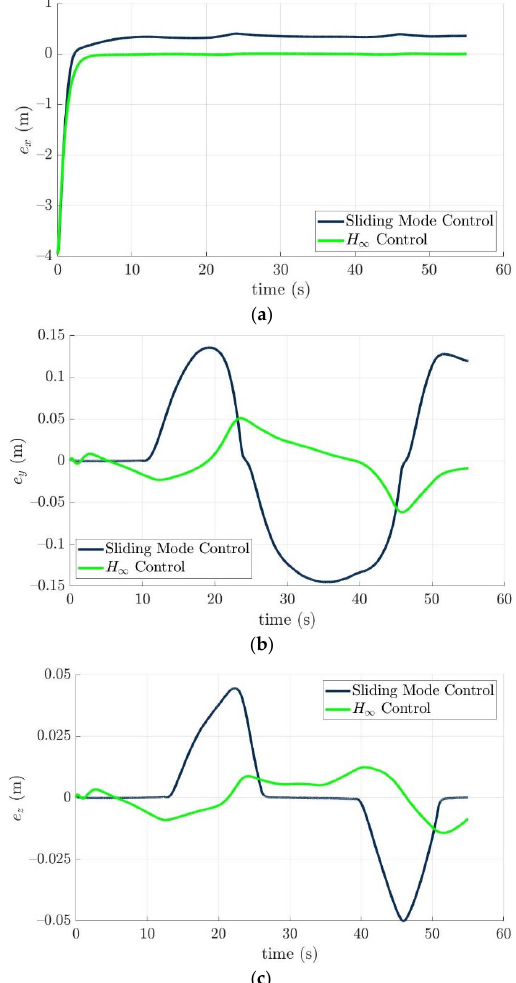
Figure 12. Histories of the position tracking errors of the controlled torpedo-like underwater vehicle: ( a ) x-axis, ( b ) y-axis, and ( c ) z-axis.